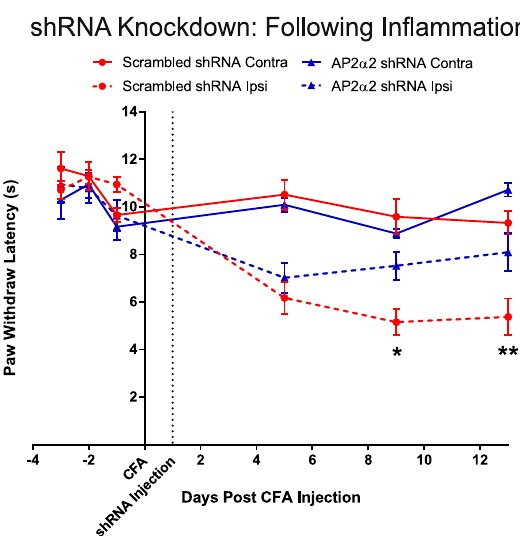
unprecedented; however, our implementation of a one-phase exponential decay approach allowed for a more comprehensive understanding of the kinetics of thermal recovery following a single-dose administration paradigm, which may prove important for the development of clinically relevant analgesics. Taken together, application of the AP2 inhibitor peptide resulted in a to control ( τ control = 4.29; Fig. 4d). Again, separation of the composite data set by sex uncovered a difference between male and female recovery kinetics during in fl ammation. Male